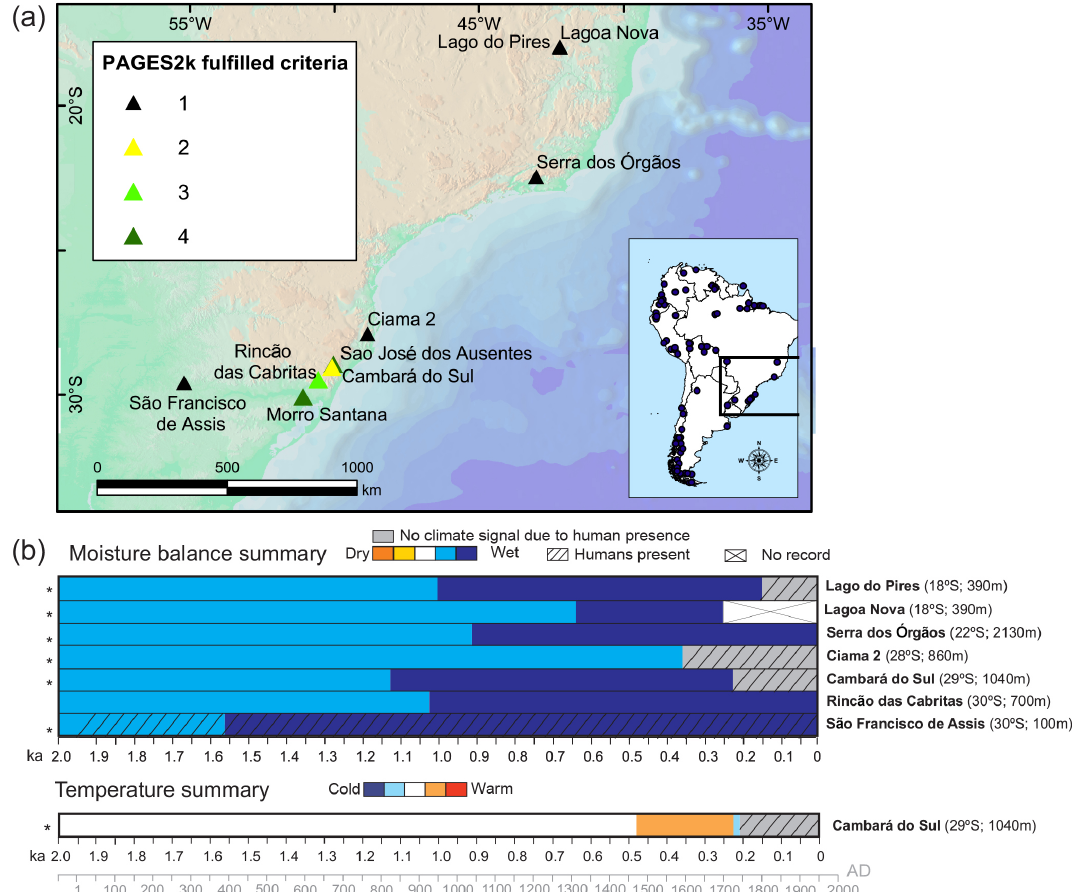
Figure 11. Panel (a) : map showing the pollen records discussed in southern and southeastern Brazil and the number of PAGES-2k criteria these records fulfill. Panel (b) : summary of moisture balance and temperature including human interference for the pollen records discussed. Not all records are suitable to derive both a moisture and a temperature signal. Climate and human presence are shown overlapping when the pollen record is not conclusive regarding the derived signal. Bars are shaded grey when the climate signal is obscured by human interference. Records fulfilling one or two criteria indicated by